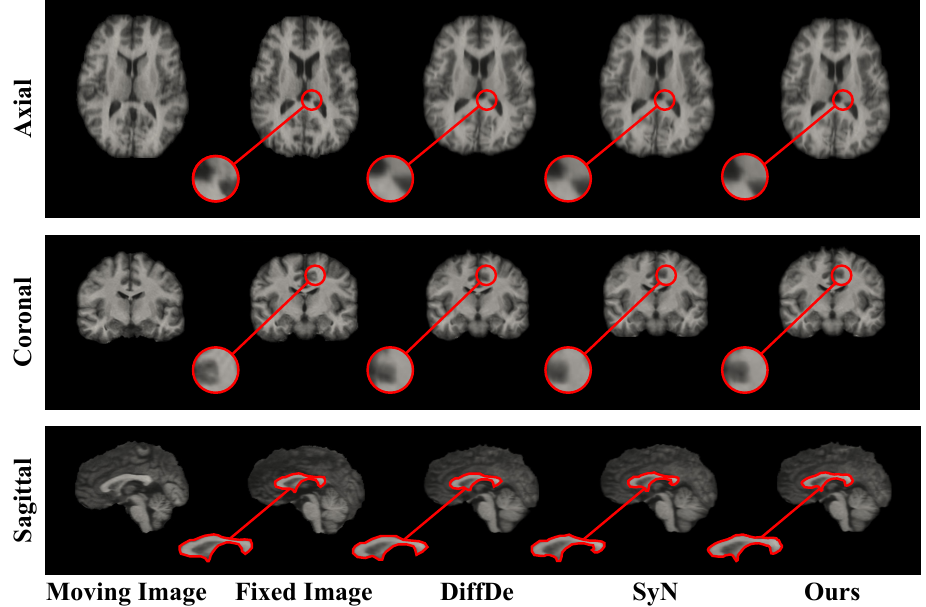
Figure 8. The registration results of an example in Section 3.4 are shown. All images are plotted in the axial, coronal, and sagittal sections. The first column displays the moving image #02, and the second column displays the fixed image #01. The third to fifth columns represent the warped moving images of different methods, i.e., DiffDe , SyN , and Ours ,